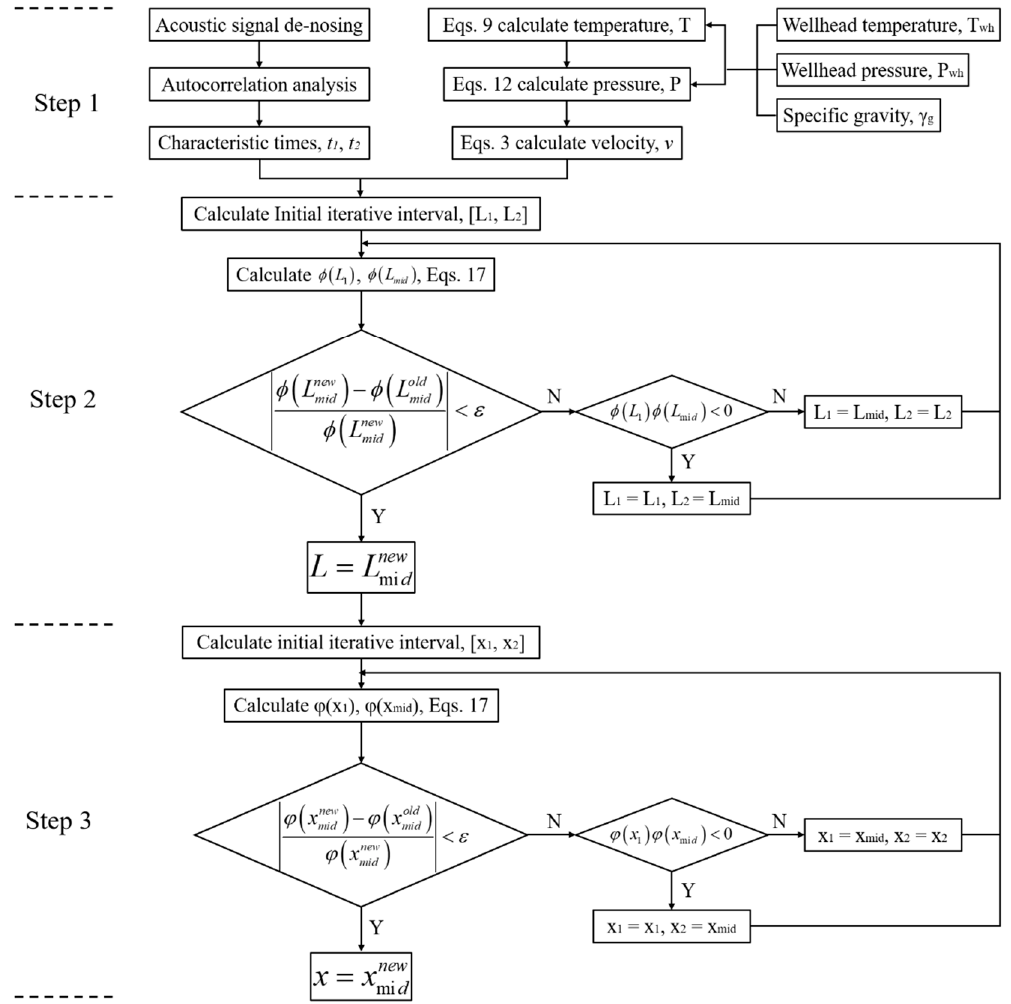
Figure 5. Flowchart of the downhole tubing leakage localization algorithm.